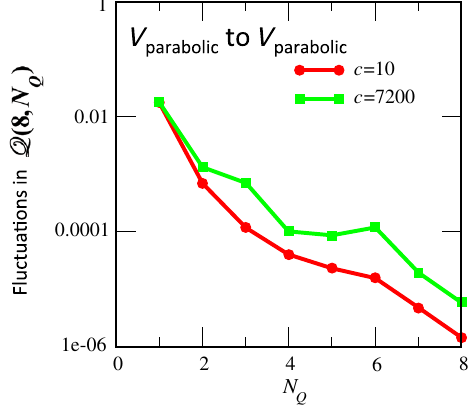
FIG. 7. We show that the fluctuations in the effective charges Q constructed from a quench from a stronger to a weaker parabolic potential, like their parabola to cosine counterparts, die out rapidly with N Q . We consider two quenches of this type, one with the gas at c ¼ 7200 and one with c ¼ 10 . For the c ¼ 7200 case, we quench from a parabolic potential with strength, ω 0 ; init L 2 = 2 E 6 . 48 into a parabolic potential with given by m ω 2 0 ; F ¼ init L 2 = 2 E 2 . 11 . And for the given by m ω 2 0 ; strength ω 0 ; F ¼ fin fin c ¼ 10 case, we quench from a parabola described by L 2 = 2 E 3 . 24 into one given by m ω 2 L 2 = 2 E 1 . 06 m ω 2 F ¼ F ¼ 0 ; init 0 ; fin Fig. 7, we show the fluctuations in Q ð N Q Þ as a function of the number N Q of Lieb-Liniger charges used to construct Q .